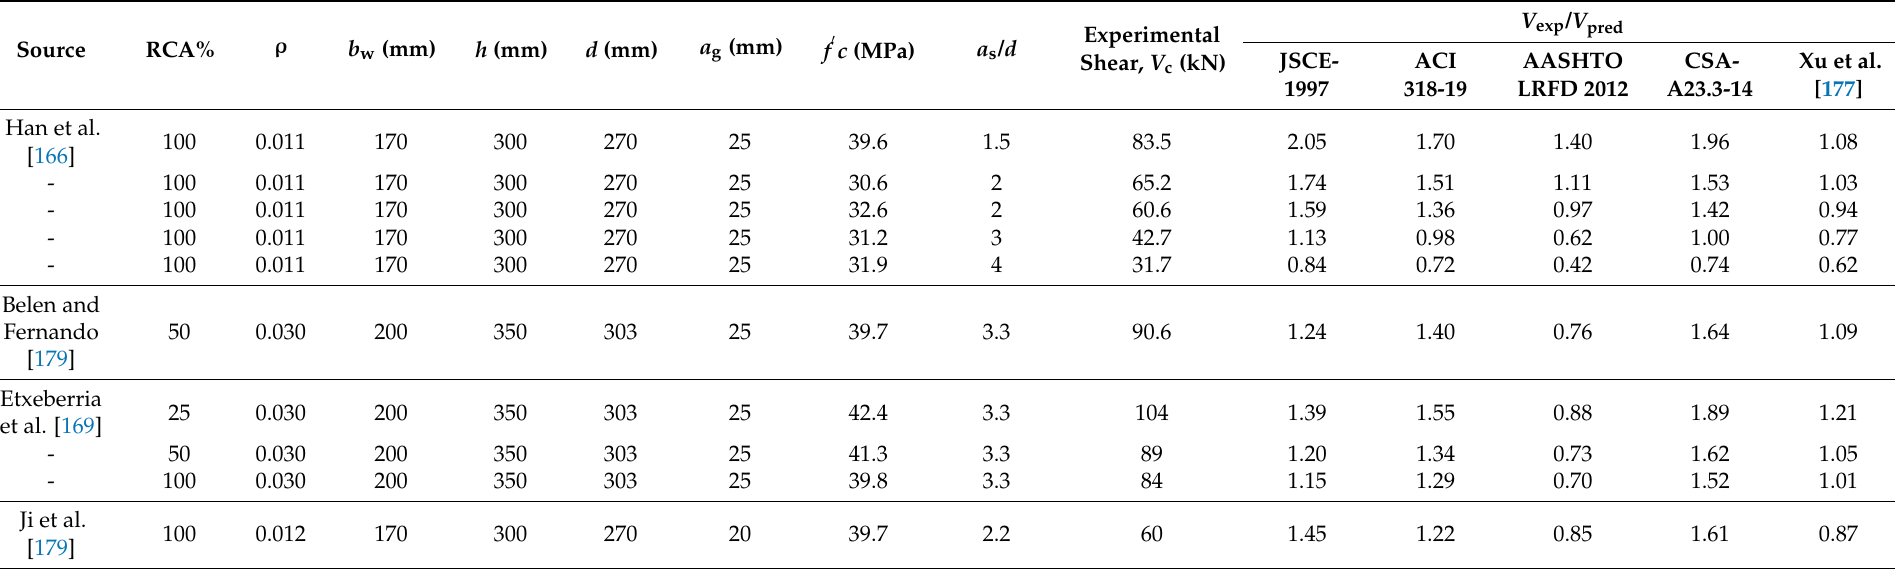
Table 3. Experimental and predicted shear capacities for reinforced concrete beams with partial or total